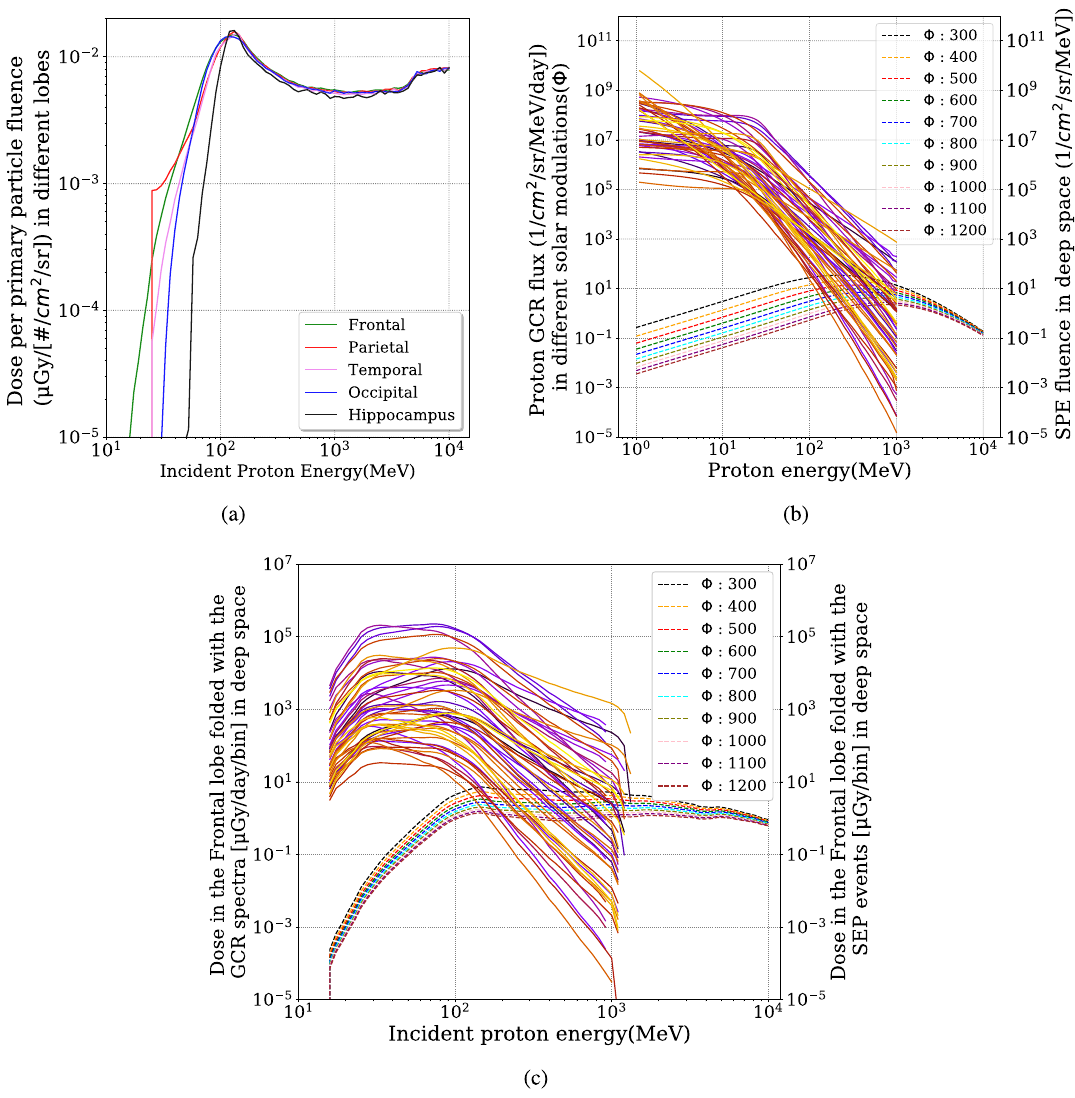
Figure 2. Folding the Brain Response Functions (BRFs) with primary GCR/SEP protons to calculate the dose rate inside different lobes, and in the hippocampus region of the brain as described in “Application of the simulated results—the procedure to apply our ready functions for calculating the resulted radiation inside a brain”. ( a ) BRFs as calculated in 41 for protons. ( b ) Energy- and time-differential flux of GCRs under different solar modulation potential (MV) (dashed curves) and the energy-differential but event time-integrated fluence of SEP events (solid lines) in deep space. ( c ) Convolutions of the GCR/SEP particle spectra of panel ( b ) with the BRF for the frontal